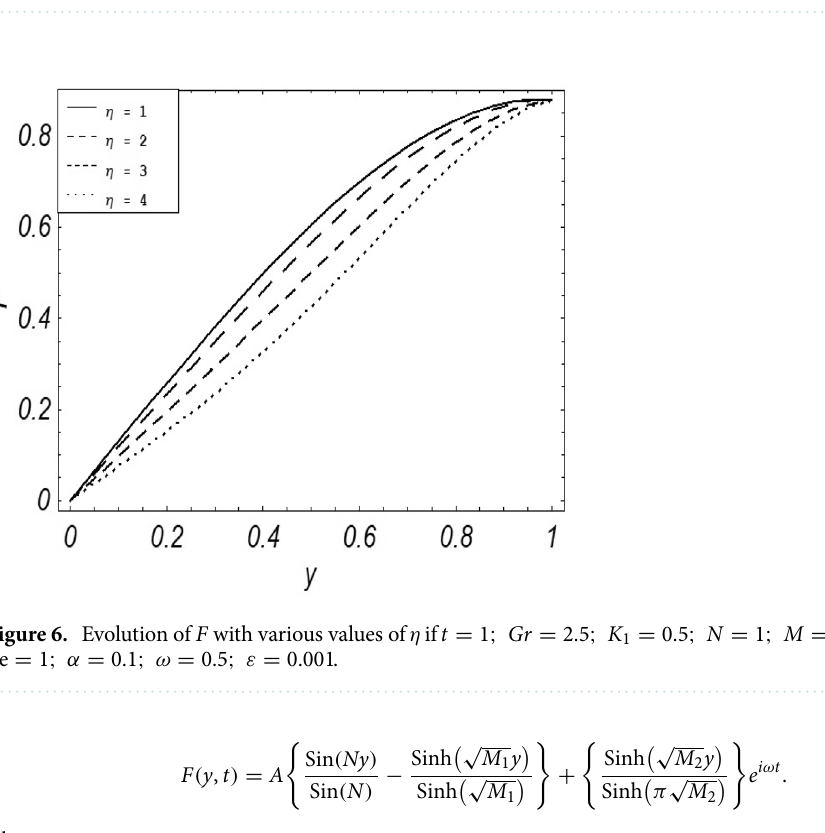
Figure 5. Evolution of F with various values of Gr if t = 1 ; N = 0.7 ; K = 0.5 ; η = 2 ; N = 1 � = 0.5 ; Re = 1 ; α = 0.1 ; ω = 0.5 ; ε = 0.001 .